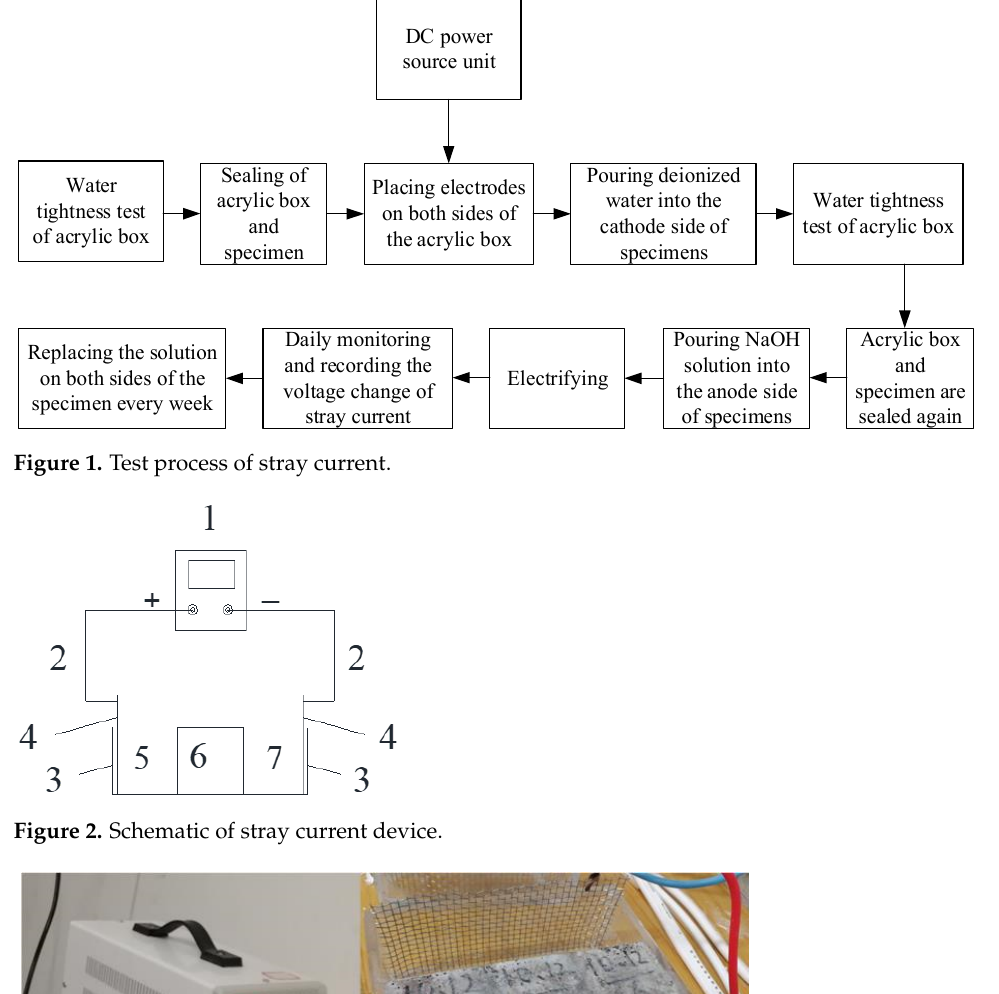
Figure 2. Schematic of stray current device.